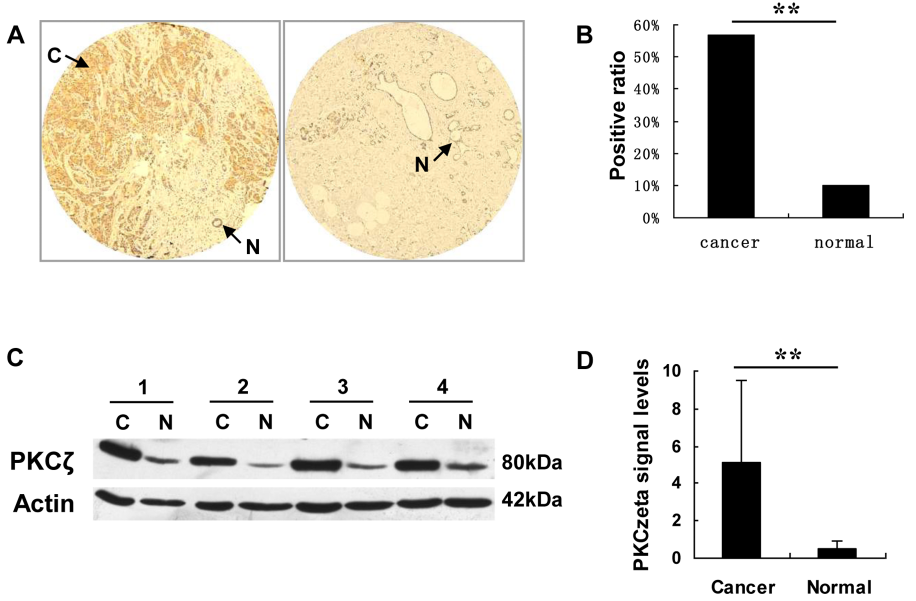
Figure 1. PKC f is expressed strongly in invasive tissue, but weakly/not in normal tissue. A) IHC images of TMA analysis from a paired invasive ductal carcinoma case. Arrows point to areas of carcinoma (C) or normal (N) tissue. B) Positive ratio of PKC f staining in TMA, 56.7% (17 of 30 cases) in invasive samples and 10% (3 of 30 cases) in normal samples. **, p , 0.001 by Fisher’s exact test. C) Western blots of PKC f and actin from four paired cases; carcinoma (C) and normal (N) samples. D) Relative PKC f levels in western blots. PKC f levels were normalized by ß-actin levels as loading